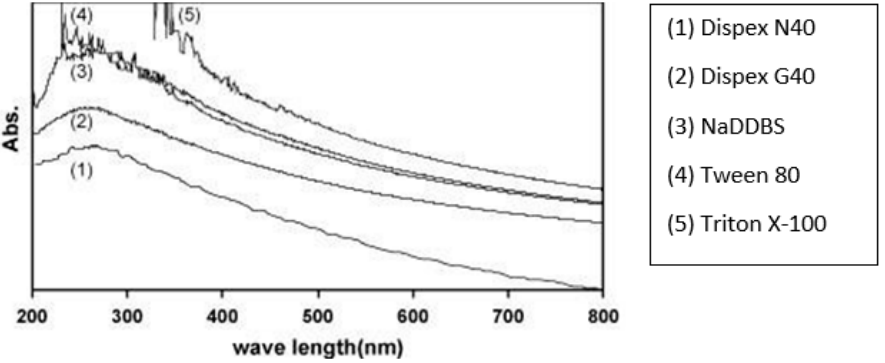
Figure 5. UV–vis absorption spectra of carbon black in presence of various dispersant. Reproduced with permission from [80], Elsevier, 2009.